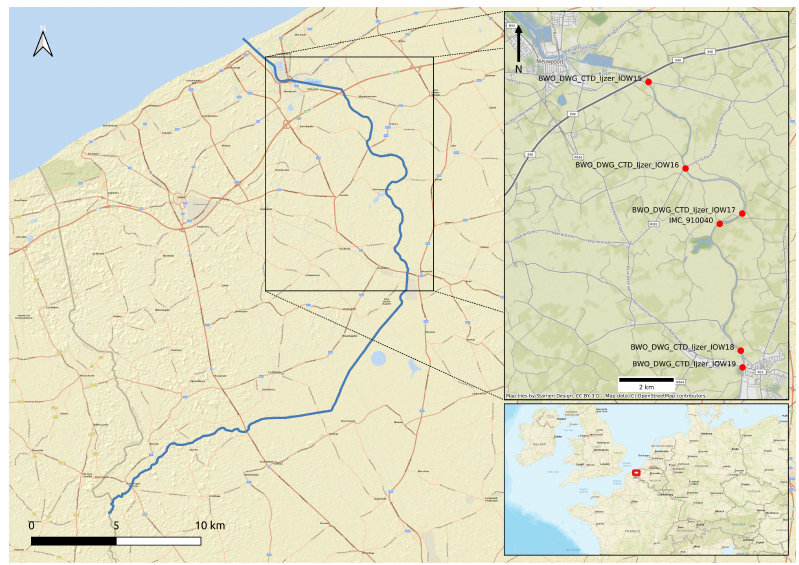
Figure 11. An overview of the Yser river in the North West of Belgium and a more detailed view of the station placement used in the queries.